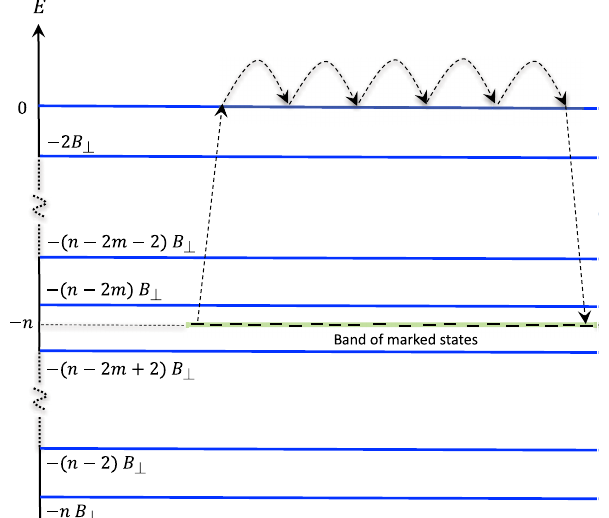
FIG. 1. Cartoon of the level diagram. Horizontal blue lines depict the energy levels − B ⊥ ð n − 2 m Þ of the driver Hamiltonian H in Eq. (1) separated by 2 B ⊥ . A narrow impurity band of width D W ≪ B ⊥ is marked in light green. The sequence of short black lines depicts the energies of marked states E ð z depict the elementary path to the leading-order perturbation theory in B ⊥ for the tunneling matrix element c Eq. (19). In this paper, we focus on the case of relatively large transverse fields B ⊥ > 1 so that the IB energies lie above the ground state of the total Hamiltonian (1) that corresponds to nearly all qubits polarized in the x